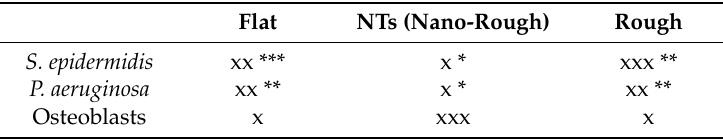
Table 2. Summarized comparison between the physicochemical surface properties and the optimum surface option for cellular behavior. ‘x’ represents low viability, ‘xx’ indicates regular viability, and ‘xxx’ strong viability. ‘*’ expressed low adhesion, ‘**’ displayd regular adhesion, and ‘***’ announces high adhesion. Flat NTs (Nano-Rough)